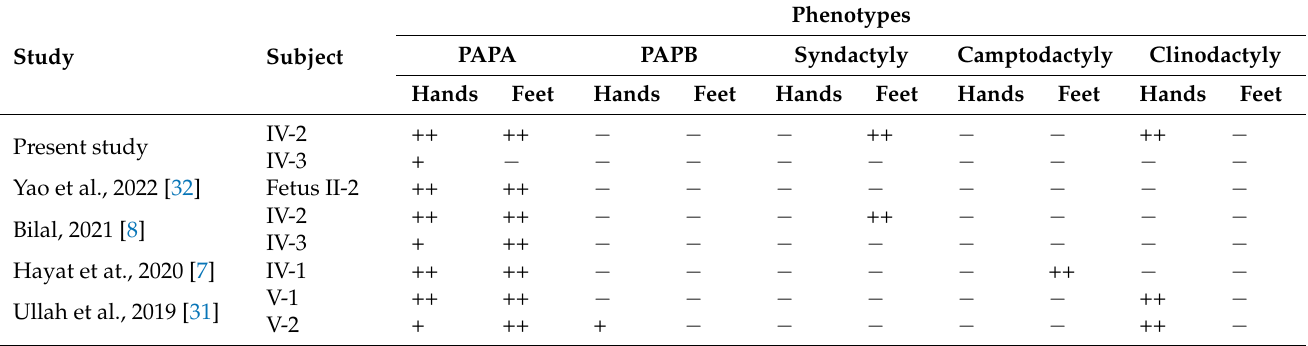
Table 4. Phenotypic comparison of the patients in the present study with previously reported patients with pathogenic variants in KIAA0825